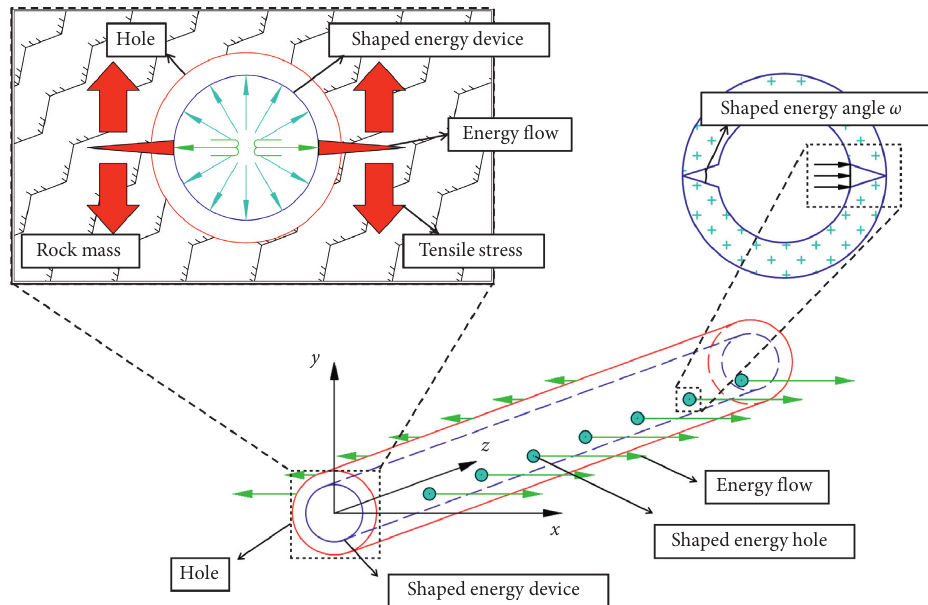
Figure 1: Principle and device of bidirectional cumulative tension blasting.